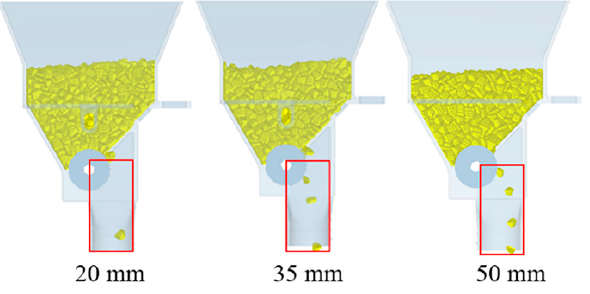
Figure 13. Comparison of uniformity of discharged seed for different lengths of grooved wheels.